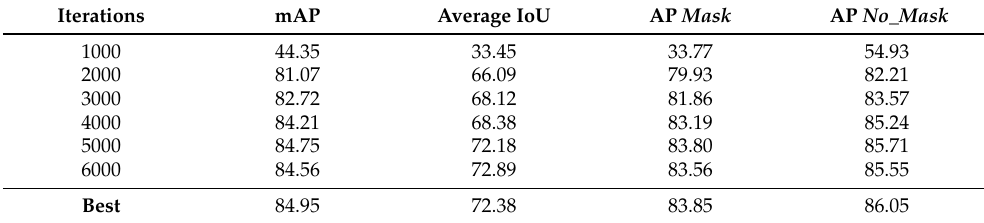
Figure 6. Performances of ( a ) YOLOv3, ( b ) YOLOv4, and ( c ) YOLOv4-tiny models in terms of average loss and mAP. Table 4. Performance of YOLOv3.